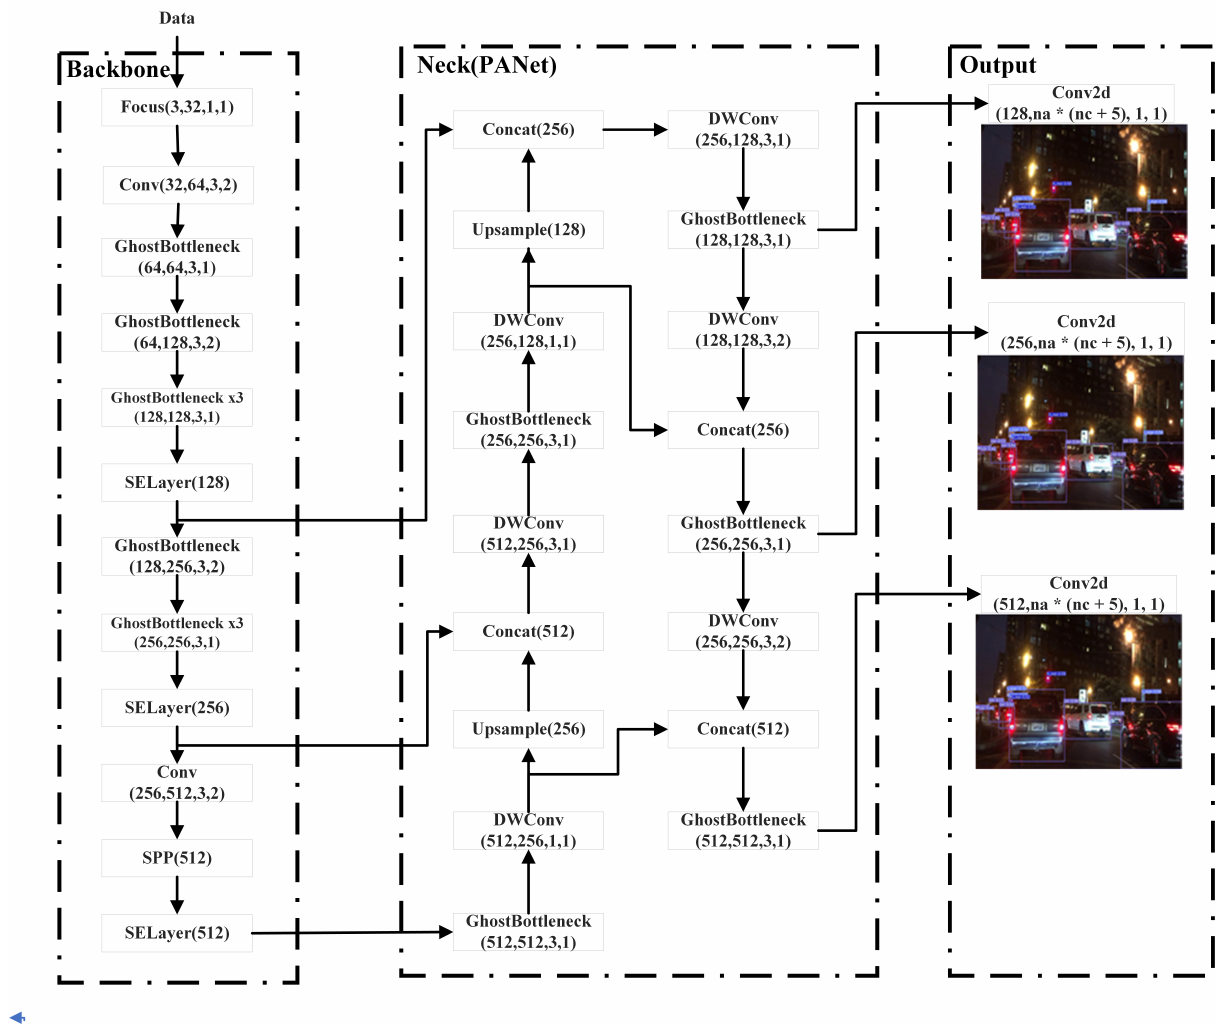
Fig. 1. Whole network structure